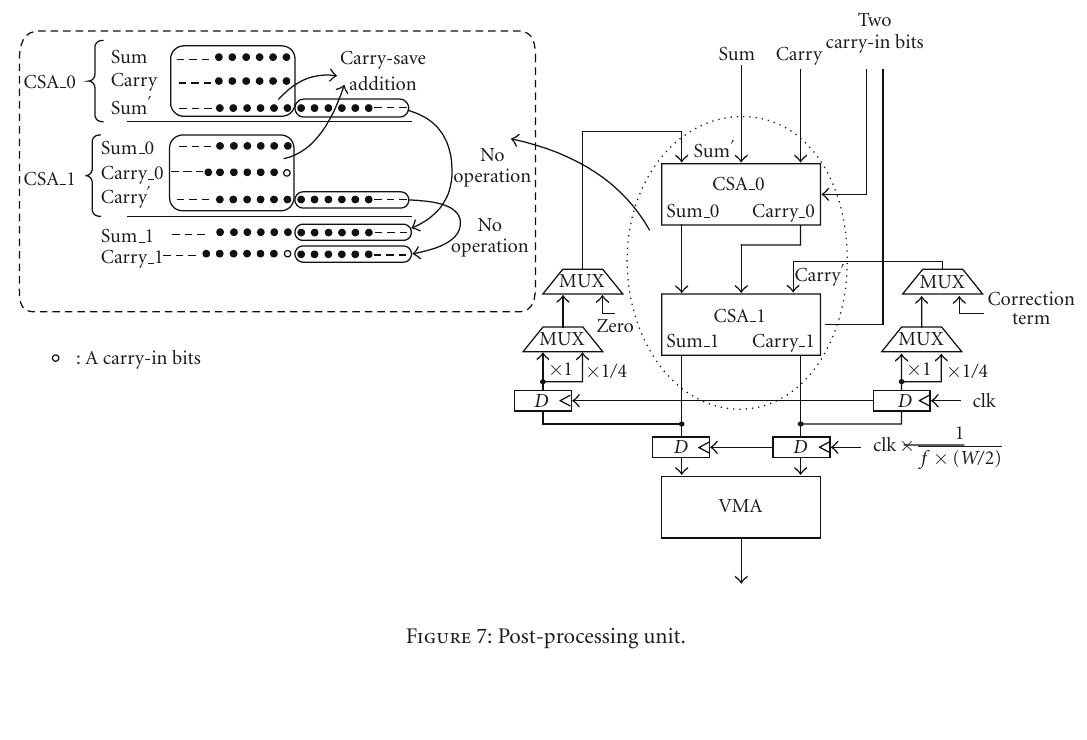
Figure 7: Post-processing unit.